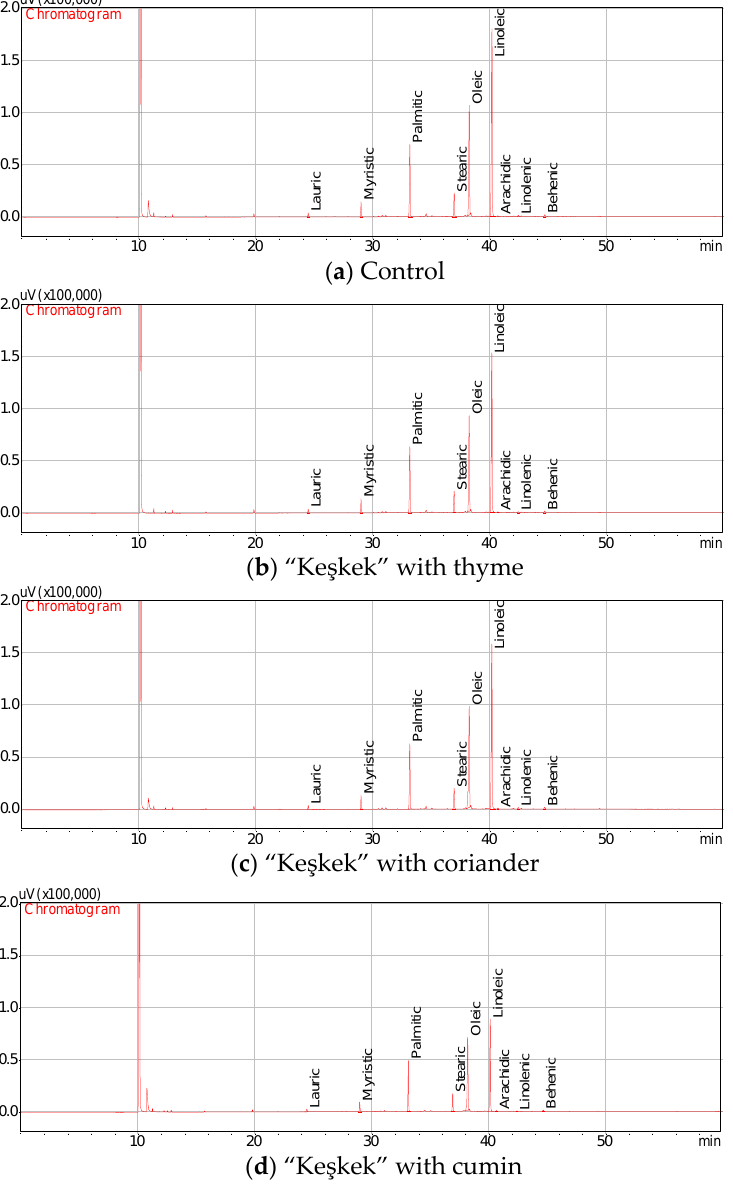
Figure 2. Fatty acid chromatograms of the oils of control and “Keşkek” samples ( a – d ) with spice added.